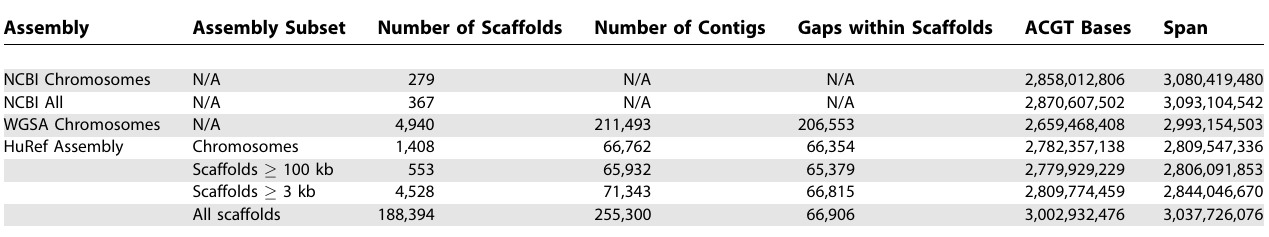
Table 2. Summary of HuRef Assembly Statistics and Comparison to the Human NCBI Genome Assembly